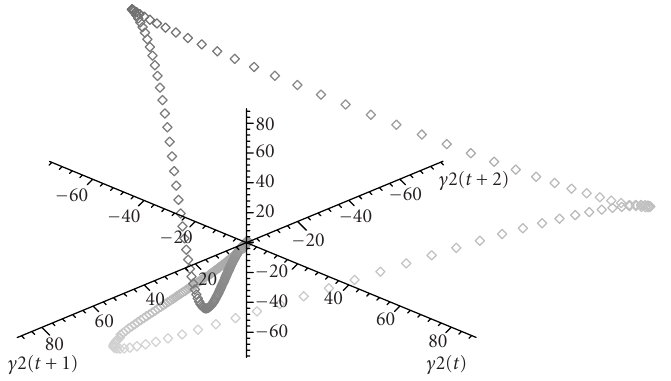
Figure 5.9. The time series for ε ( τ ) on a three-dimensional space corresponding to shift by 20 time steps.